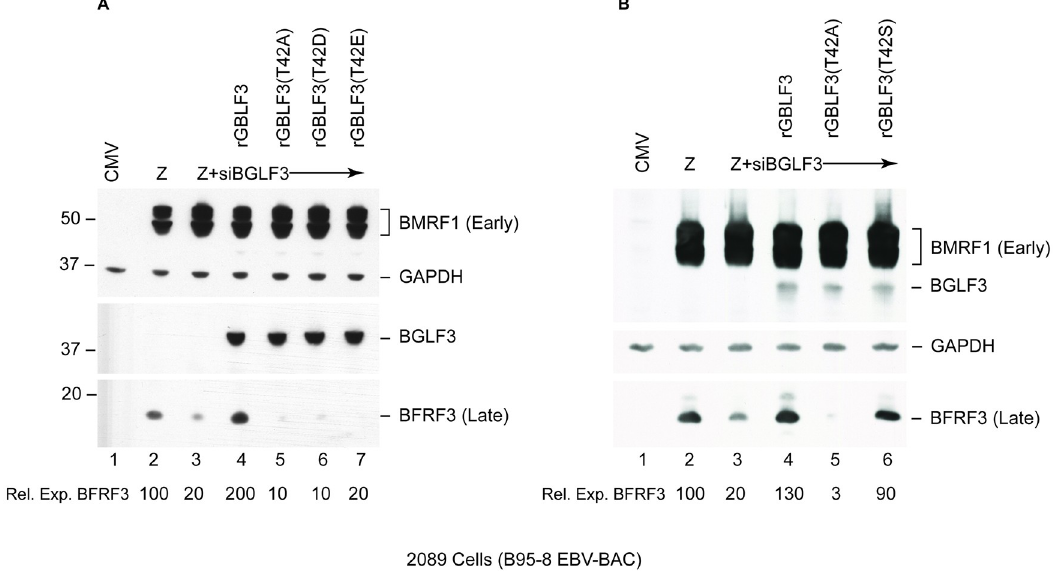
Fig 3. Phosphorylatable BGLF3(T42S) maintains expression of late genes. Western blot analysis assessing the effect of mutating BGLF3 at position 42 to phosphomimetic aspartate or glutamate (A) and to phosphorylatable serine (B). 2089 cells were transfected with the indicated expression vectors. Expression of endogenous BGLF3 was suppressed using siRNA to BGLF3 (siBGLF3). siRNA- resistant wild type BGLF3 (rBGLF3) was transfected to restore late gene expression. To examine the capacity of the phosphomimetic and phosphorylatale residues to restore late gene expression we transfected rBGLF3(T42D), rBGLF3(T42E) and rBGLF3(T42S). Cell lysates were analyzed after 48h by immunoblotting using antibodies specific to early BMRF1, FLAG epitope for BGLF3, GAPDH, and late